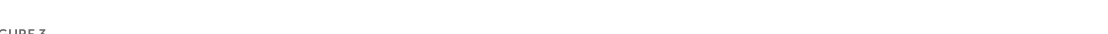
FIGURE3 Finally, NC-balloons of different figures were selected to expand the stents under high pressure (20–24 atm) (d) , and angiography showed that the stents were fully expanded with a blood flow of TIMI 3 (e,f) . Case 5 : An example of PCI using the GGEC I in CTO of the RCA with abnormal opening. Angiography showed that the ascending aorta was significantly widened, the end of RCA 2 segment showed localized occlusion, and the bridging collaterals supplied blood to make the distal vessels partially visible (a) . The LAD provided the collaterals, and the RCA was retrogradely perfused to the end of segment 3 (b) . It was difficult to keep the 6F AL 1.0 guiding catheter in place, and Sion was patiently manipulated to “float” into the RCA (c) . Then, the GGEC I was slowly pushed along Sion into the RCA (d) . Sion was exchanged with Conquest pro 8–20 via the Finecross and manipulated carefully through the occluded segment (e) and into PL (f) under multi-position fluoroscopy. Under the support of the GGEC I, pre-expansion was performed using balloons of different specifications (g,h) . Finally, the stent was successfully implanted in the occlusive segment (i) . Case 6 : An example of PCI using the GGEC I to release the burr incarceration. 6F EBU 3.75 angiography showed heavy calcification in LAD 6-8 segments with about 90% stenosis (a) . Runthrough was carefully manipulated to reach the end of the LAD through the narrow lesions, and NC Trek 2.0 × 12 mm was selected for high-pressure dilatation (20–24 atm). However, the balloon was still not fully expanded, and the body had obvious indentation (b) . Rotational atherectomy was started and a 1.5-mm burr was passed through the stenosis successfully, but it was incarcerated during the third polishing process (c) . The first attempt to insert a second guidewire and dilate the stenosis near the burr with balloon was unsuccessful (d) . The rotational catheter was immediately cut off, and the GGEC I was sent into the guiding catheter. It reached the LAD 6 segment along its inner core. After wrapping it tightly with the non-invasive head end of the GGEC I (dotted white line), the burr was successfully removed from the body together with the GGEC I (e) . Finally, stents were successfully implanted after NC-balloon dilation (f)